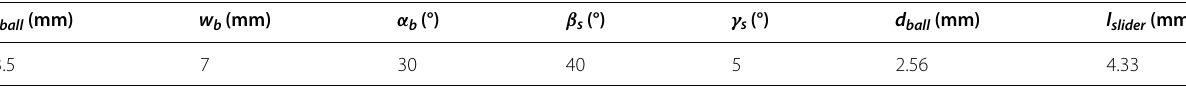
Table 1 Parameters of the RCM based on SMA